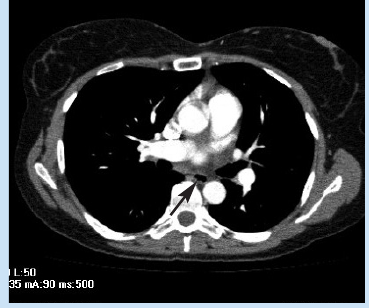
Fig. 8. Alater scan at the same table position. The IVC flow artefact has disappeared.